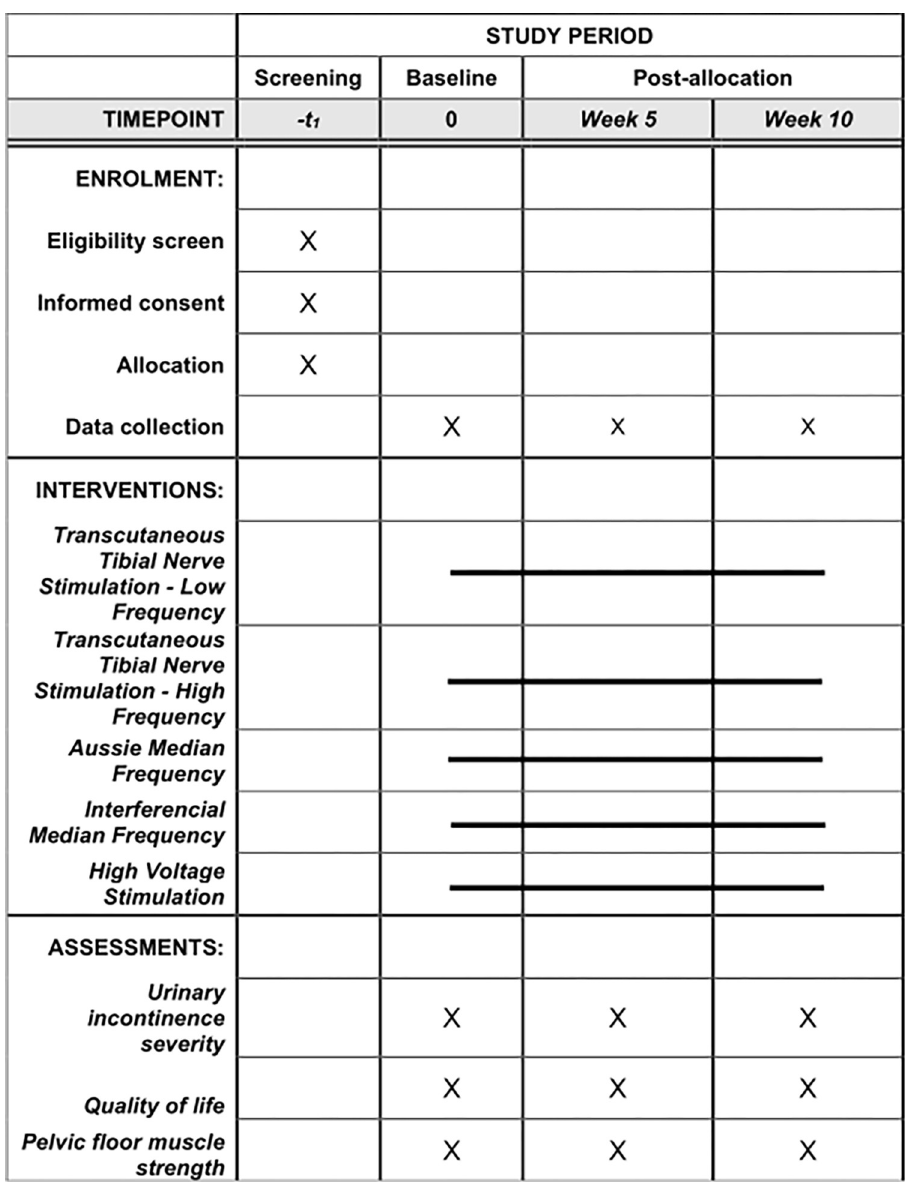
Fig 1. Schedule of the study protocol according to the standard protocol items: Recommendations for interventional trials checklist.